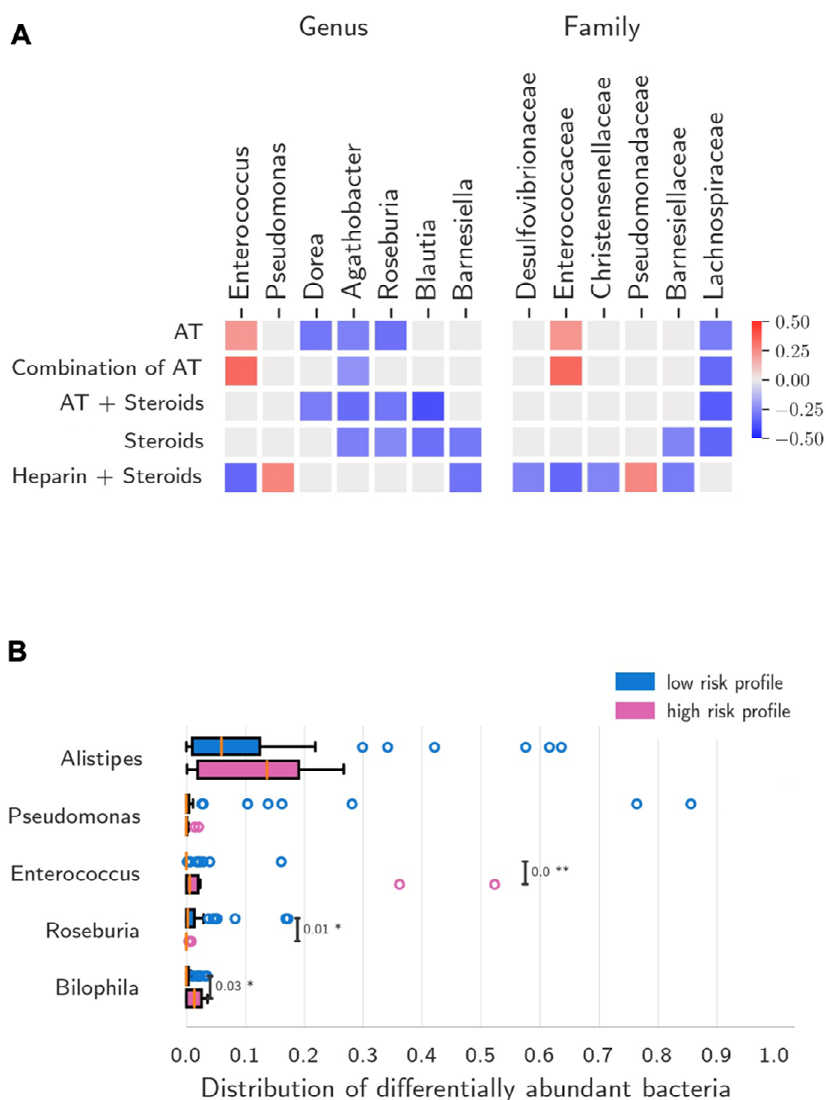
Figure 6. Gut microbiome bacteria associated with treatment and high-risk disease profile. ( A ) Gut microbiome bacteria showing positive or negative correlations with antibiotic therapy (AT) and non-antibiotic COVID-19 therapy (NACT) at genus and family levels. At the genus level, OBs such as Desulfovibrio , Akkermansia and, most frequently, Enterococcus , showed positive correlations with AT and COVID-19 treatments. Enterococcus and Pseudomonas showed negative and positive correlations with steroids and heparin combination, respectively. Roseburia , a beneficial symbiont, only showed negative correlations with treatments. Positive and negative correlations between genus abundance and days on AT and/or NACT are reported in red and blue colours, respectively. AT = any antibiotic treatment; GPB = Gram-positive bacteria; HCQ = hydroxychloroquine; LPV/r = lopinavir/r; steroids = corticosteroids. ( B ) Differences in bacterial relative abundance according to a composite index defining patients at high-risk for disease progression (IL-6 > 15.0 pg/mL, D-dimer > 500 ng/mL, ferritin > 400 ng/mL, and treatment with beta-lactam or anti-GPB antibiotics). The high-risk group showed increased relative abundance of Enterococcus and Bilophila and decreased abundance of Roseburia compared to low-risk patients. Statistical significance reported as * p ≤ 0.05, ** p ≤